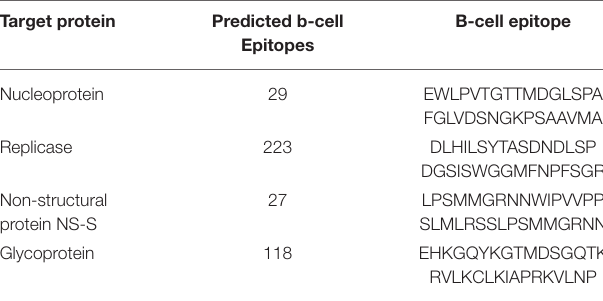
TABLE 3 | Details of total identified B-cell epitopes and shortlisted ones for the vaccine design against each target protein of